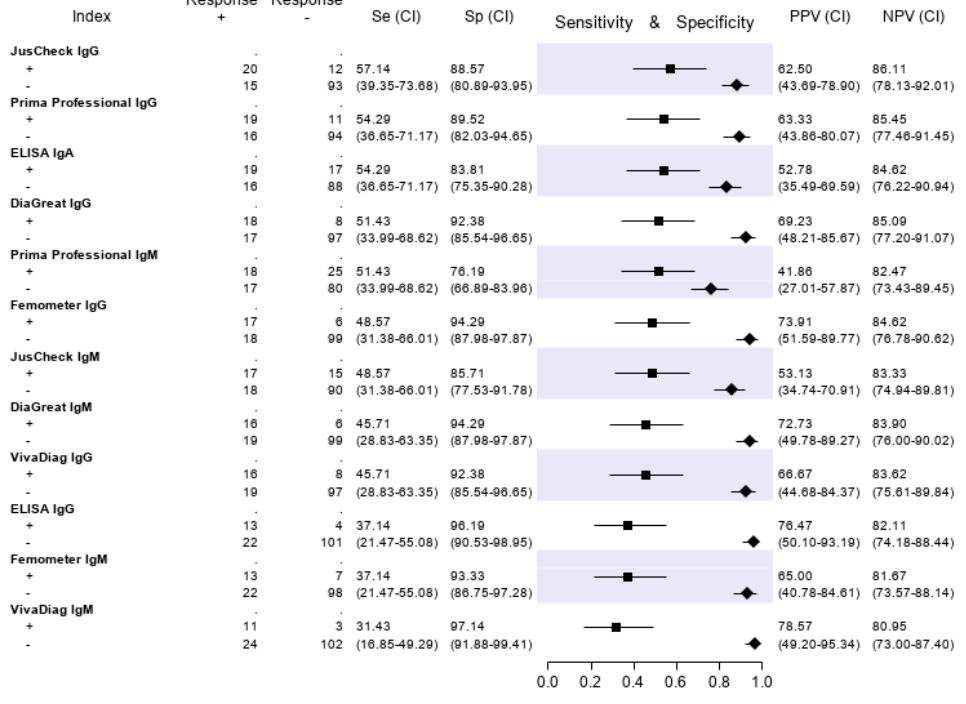
Figure 6. Test accuracies using a subset of 140 patients with a symptom duration of ≥ 7 days. Sensitivity (filled squares), specificity (filled rhombus) and predictive values of six antibody tests according to the final classification.